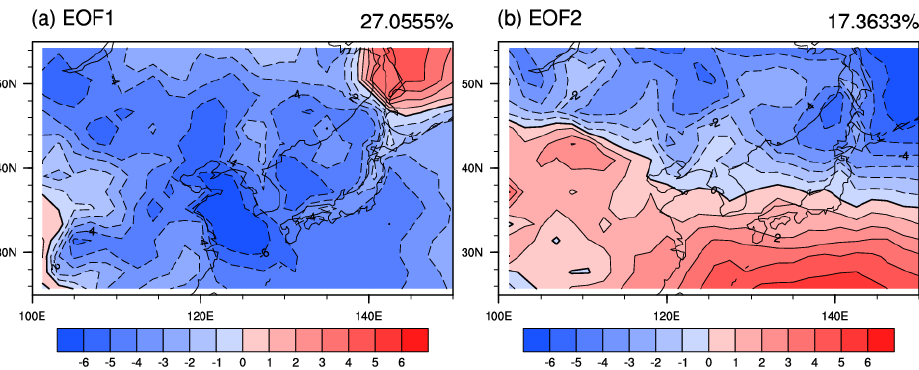
Figure 2. Spatial pattern of the first two EOF mode ( a , b ) of NCD (based on 10% threshold) in the winter during 1956–2015.